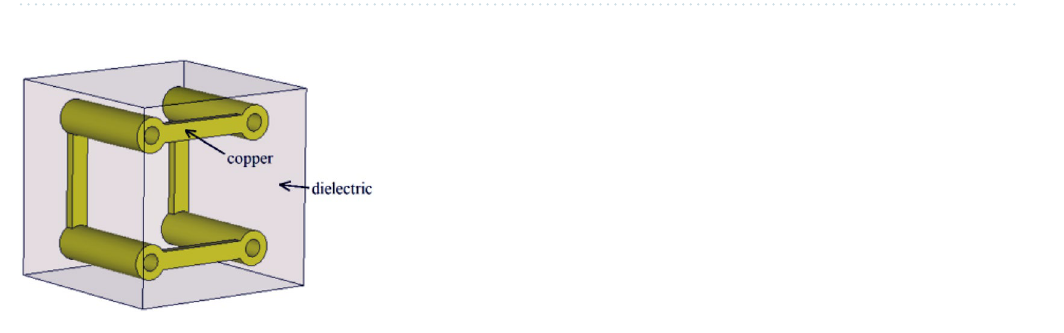
Figure 2. Bi-anisotropic chiral substrates ( a ): vertically and ( b ): horizontally oriented helices 20 .